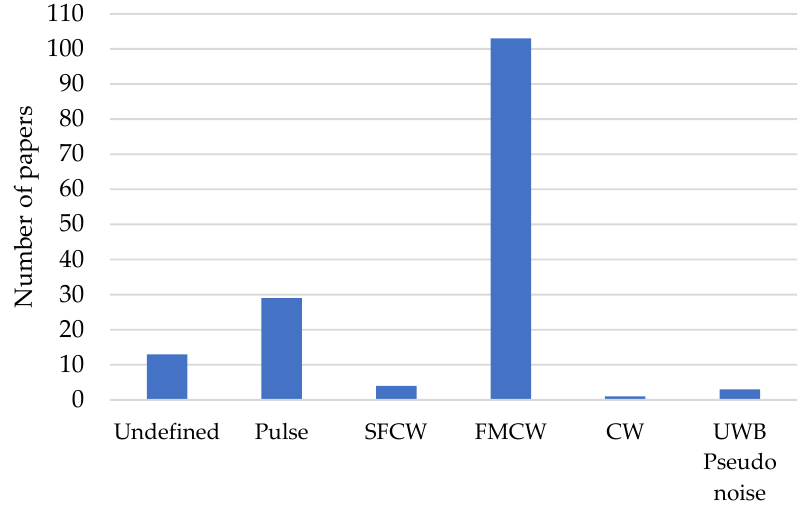
Figure 5. Number of papers in terms of radar signal.